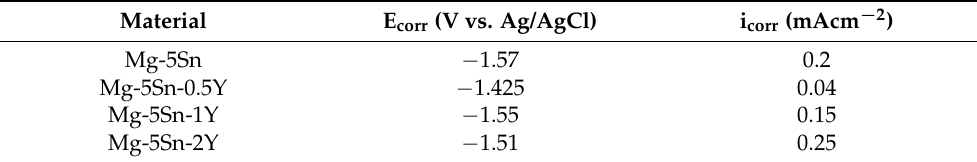
Figure 7. Potentiodynamic Polarization test results for Mg-5Sn-xY (x = 0, 0.5, 1 and 2 wt.%) alloys. Table 4. Measurements related to corrosion rate in 3.5 wt.% NaCl solution at room